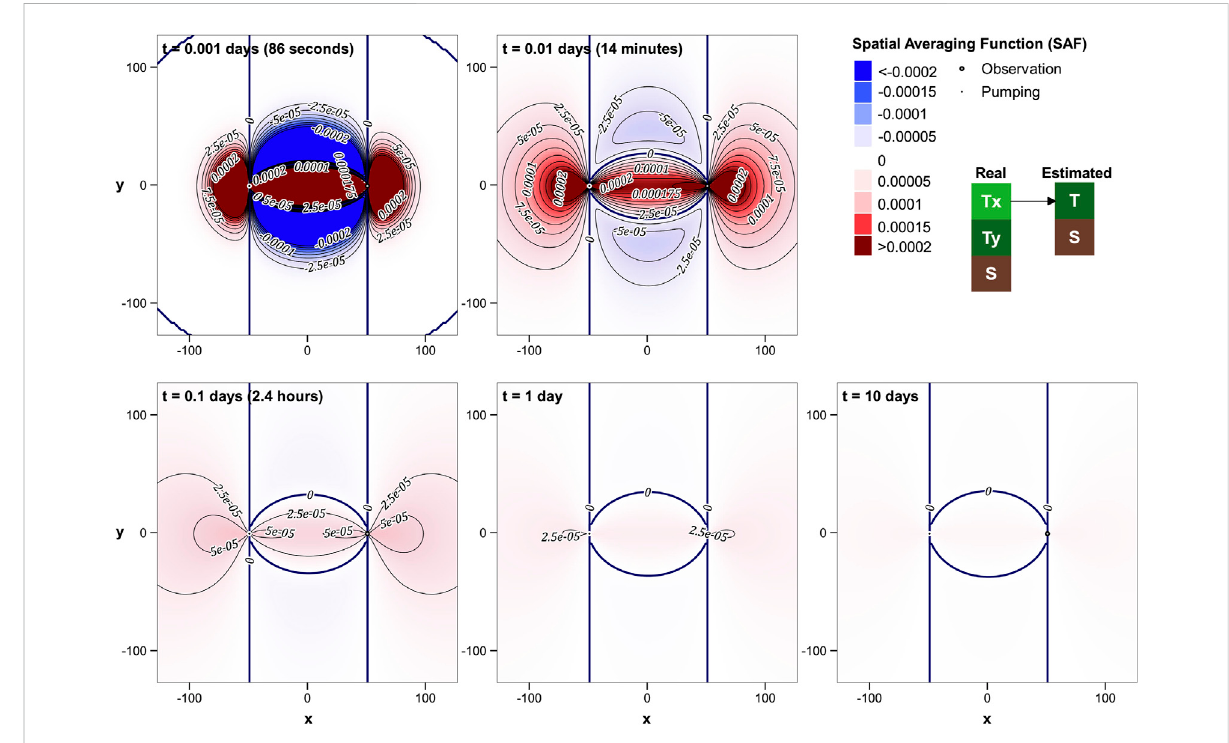
FIGURE 4 R ′ T − Tx for separated wells at fi ve different